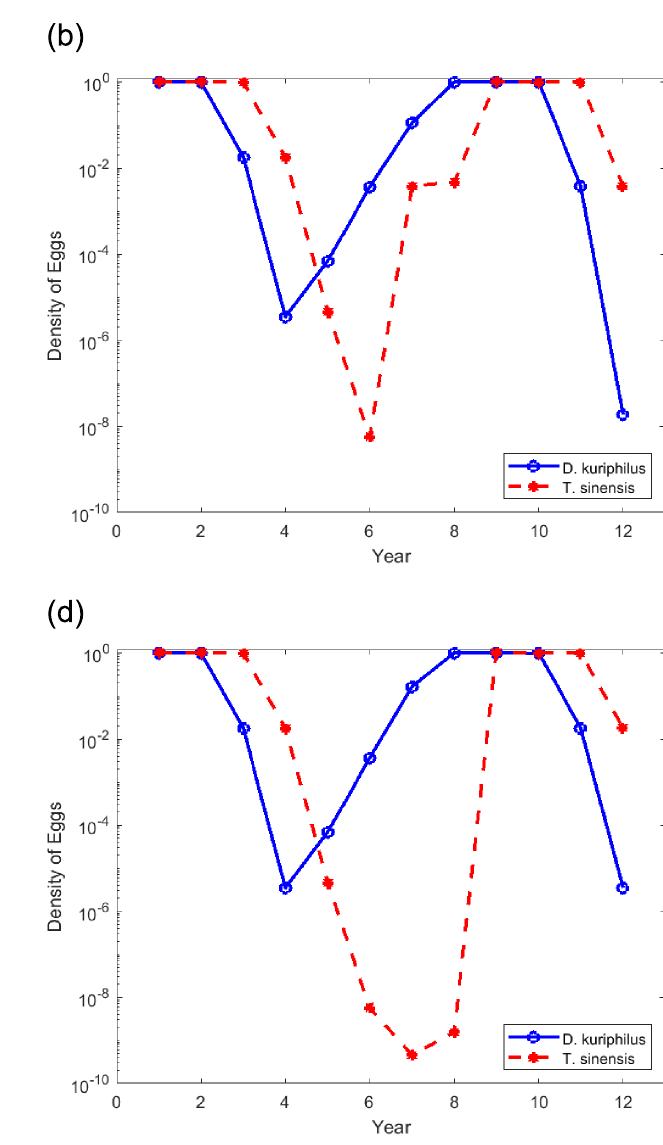
Fig 9. Egg density of D. kuriphilus ( v n ) and T. sinensis ( q n ) in a given place of the forest over the time after several release of T. sinensis made simultaneously with according to a regular mesh 4 × periodicity k r